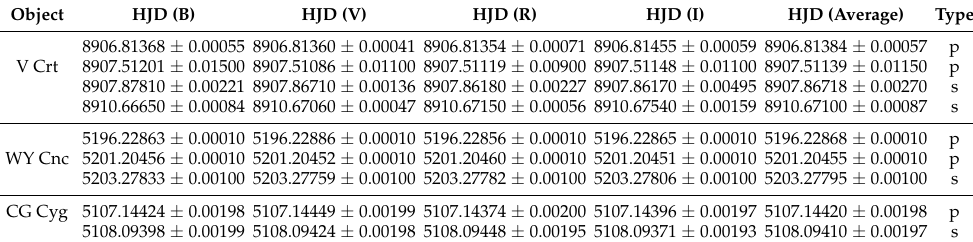
Table 3. Newly obtained minima times of three eclipsing binaries in BVRI bands.